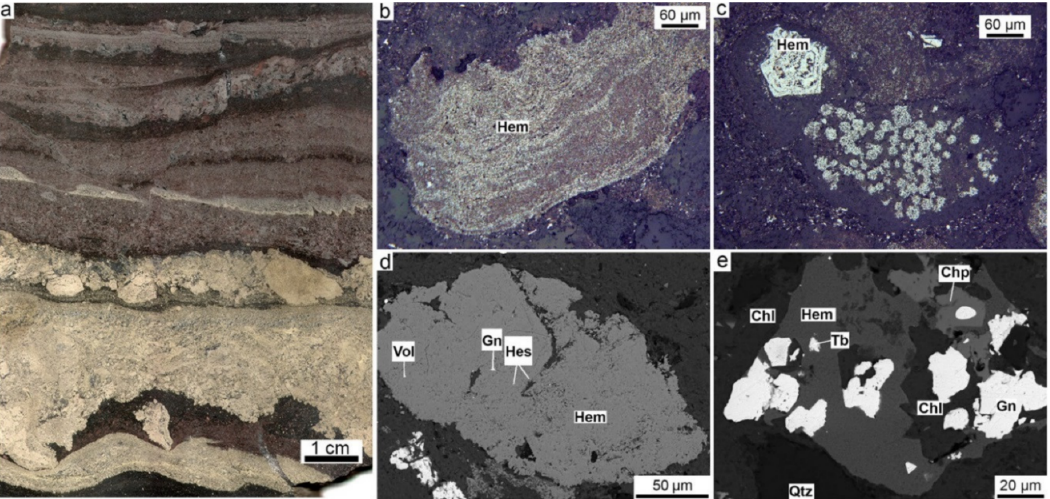
Figure 18. Mineralogical features of gossanites of the Molodezhnoe deposit: ( a ) hematite–chlorite gossanite layers intercalated with sulfide turbidites; ( b ) pseudomorphic hematite after colloform pyrite clast; ( c ) pseudomorphic hematite after zoned subhedral pyrite-2 and framboidal pyrite nodules; ( d ) inclusions of galena, hessite and volynskite in pseudomorphic hematite after pyrite clast; ( e ) intergrowth of chalcopyrite, galena and hematite with inclusions of tellurobismuthite in chlorite–quartz aggregate. ( a ) Polished samples, ( b , c ) reflected light, ( d , e ) SEM